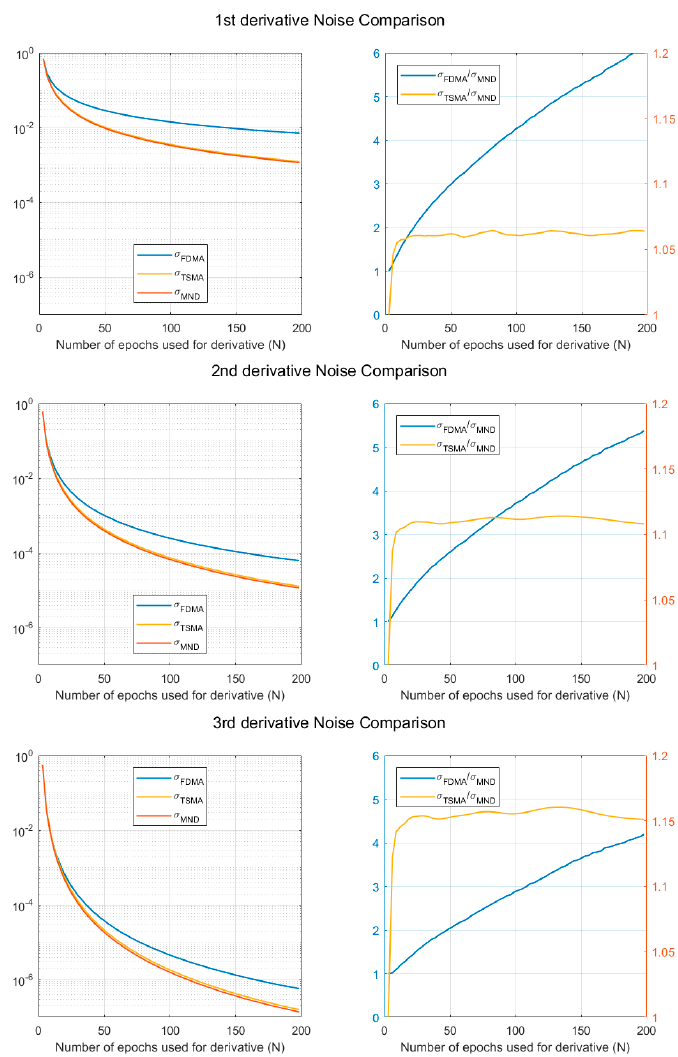
Figure 1. Noise level comparison for FDMA, TSMA, and MND .